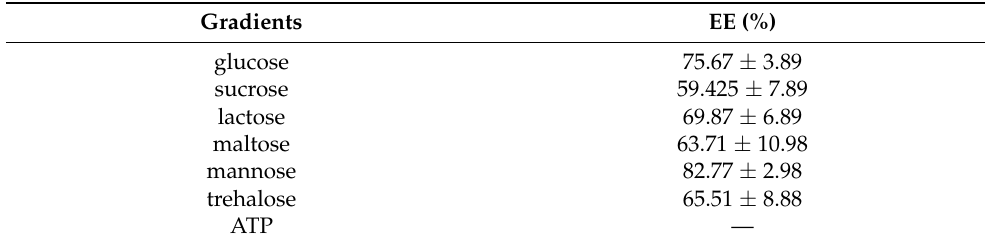
Table 4. Encapsulation efficiency of ATP and saccharides